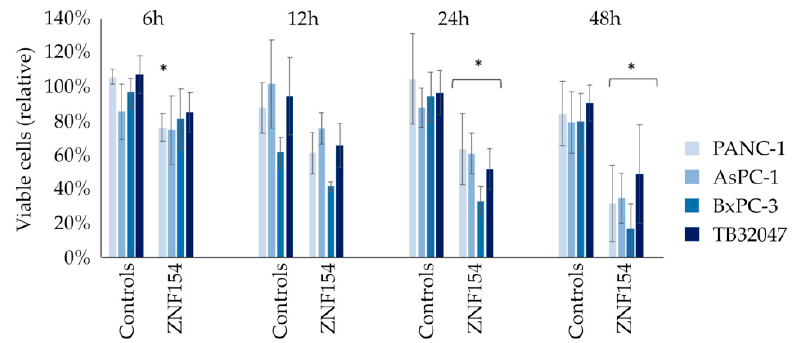
Figure 3. Percentages of viable cells following transient transfections with ZNF154 in PANC-1, AsPC-1, BxPC-3, and TB32047 cells after 6, 12, 24, and 48 h (* = p < 0.05 using student ′ s t -test).